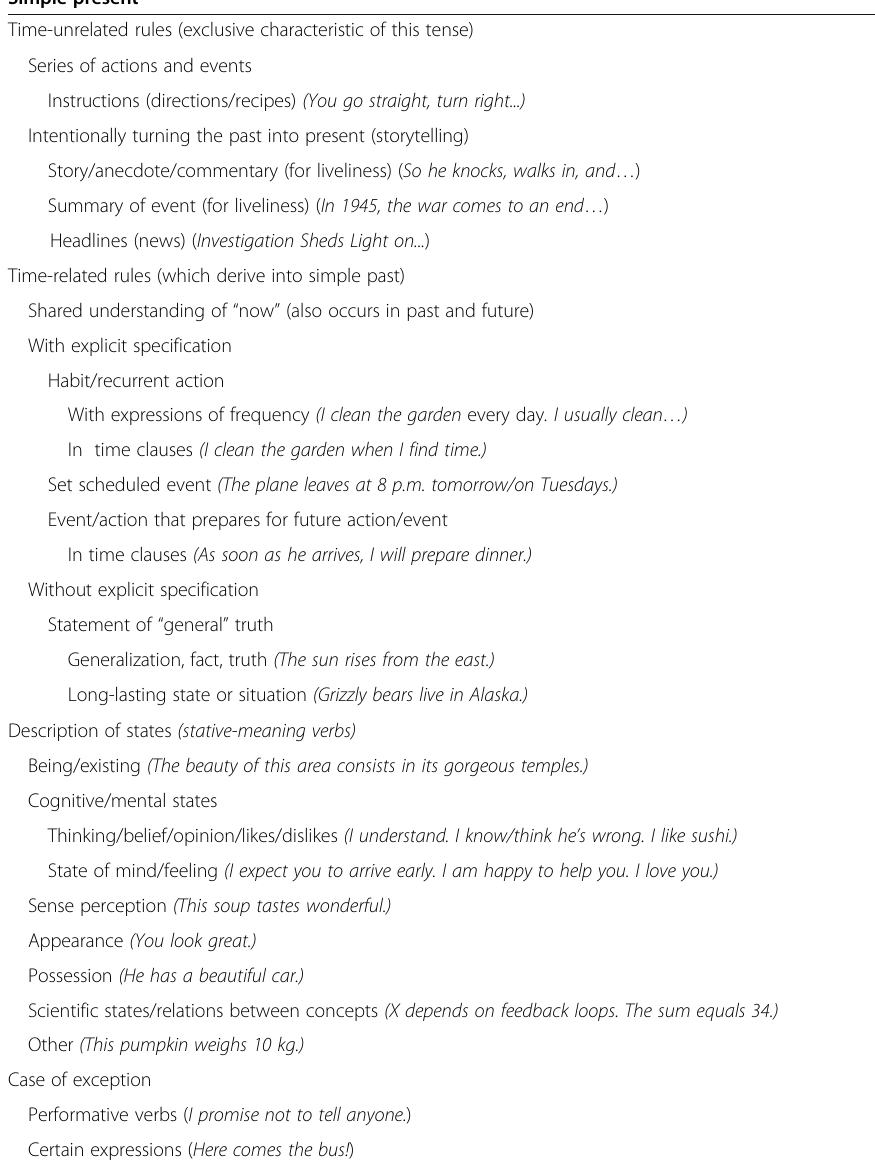
Table. 3 Simple present: an extraction of essential rules Simple present Time-unrelated rules (exclusive characteristic of this tense) Series of actions and